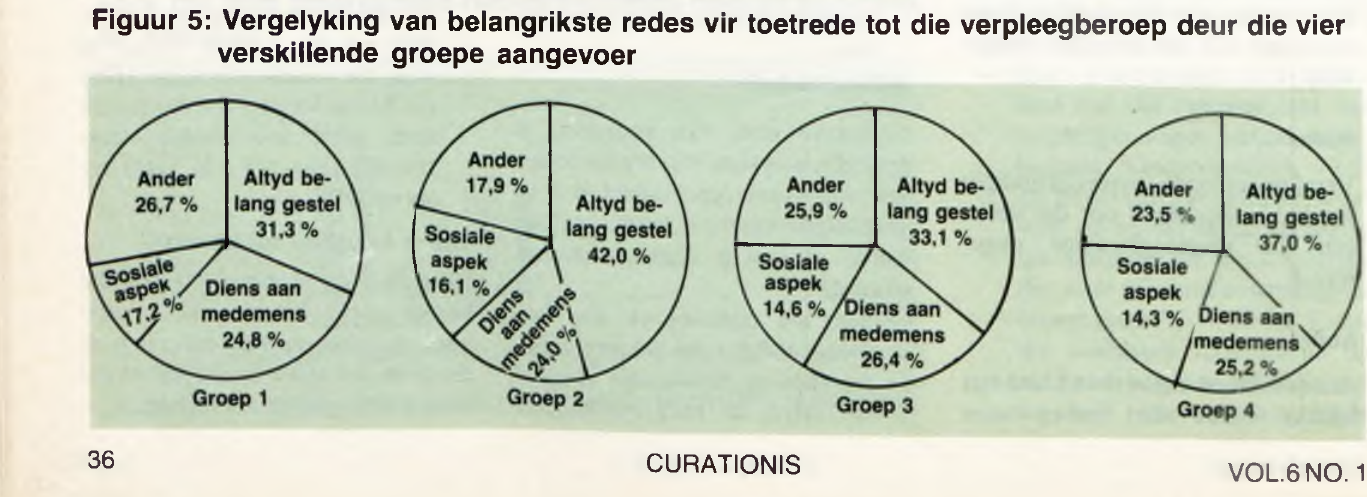
Figuur 5: Vergelyking van belangrikste redes vir toetrede tot die verpleegberoep deur die vier verskillende groepe